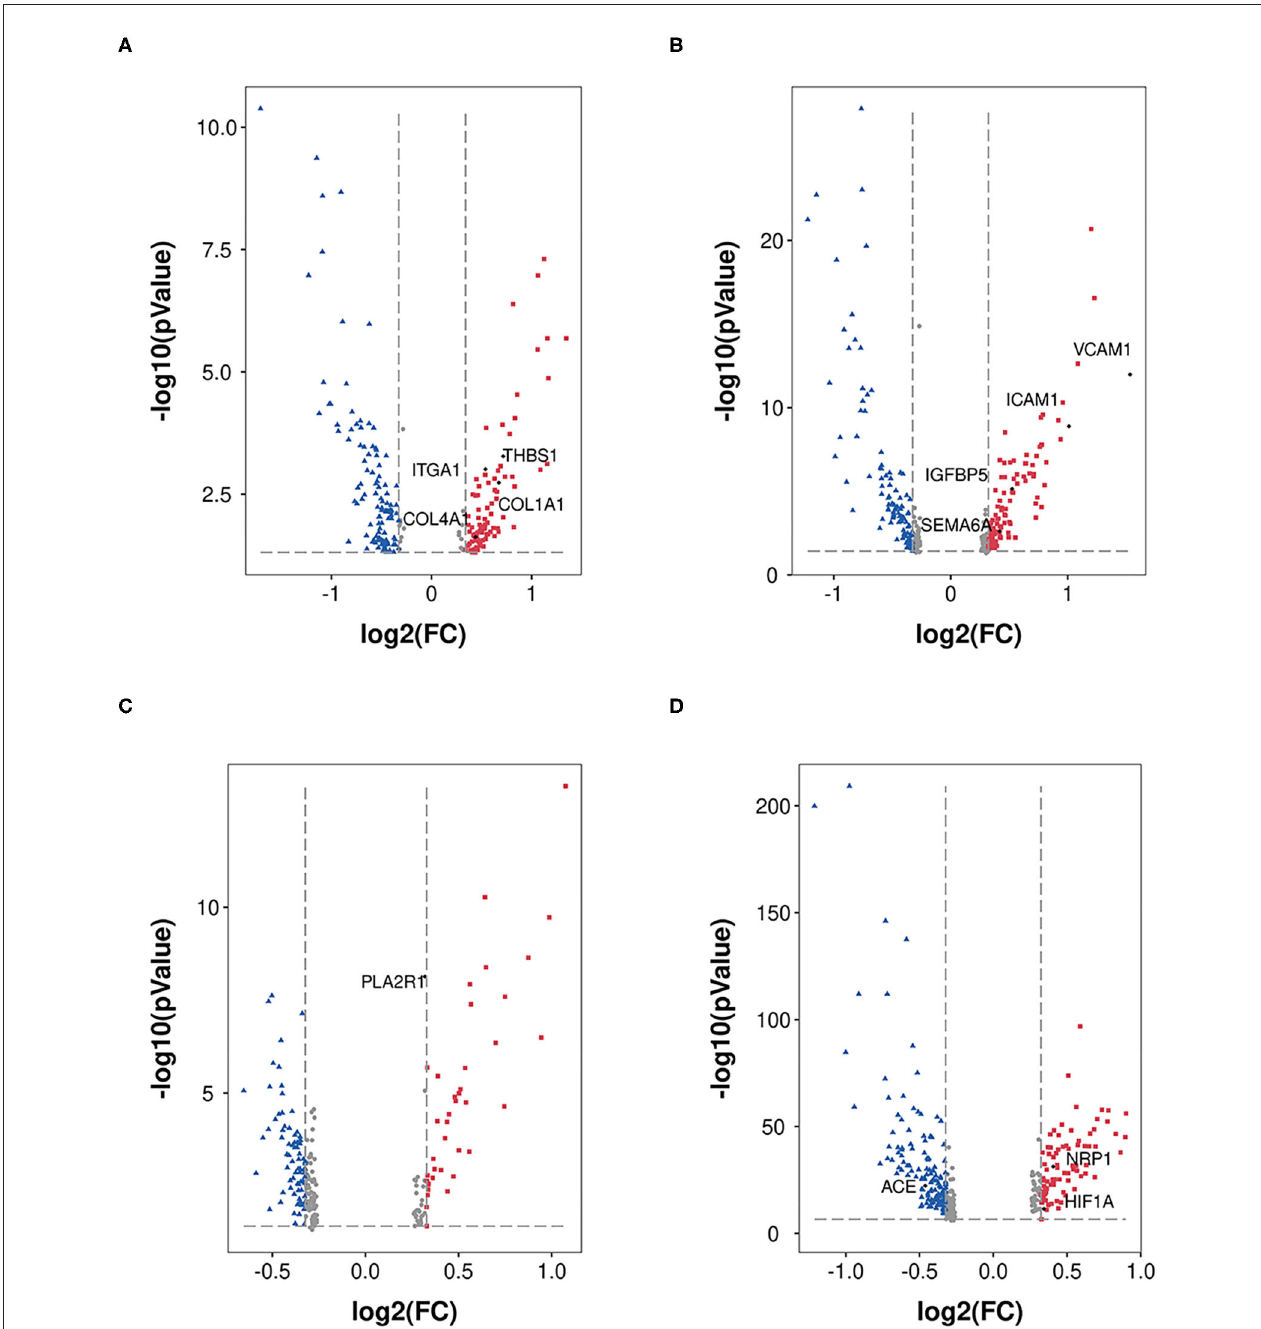
FIGURE 3 | DEGs in MES, EDC, POD, and PCT. DEGs (DKD vs. nondiabetic control) were analyzed in MES (A) , EDC (B) , POD (C) , and PCT (D) . The dots in red represent upregulated genes, and the dots in blue represent downregulated genes.